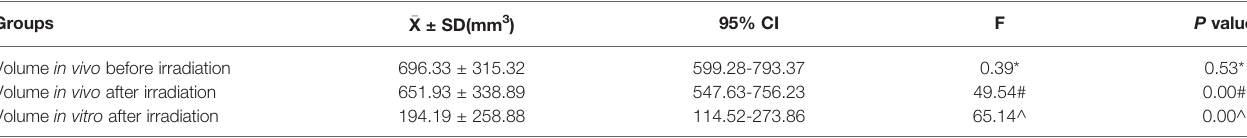
TABLE 1 | Volume comparison of implanted tumors before and after irradiation. Groups